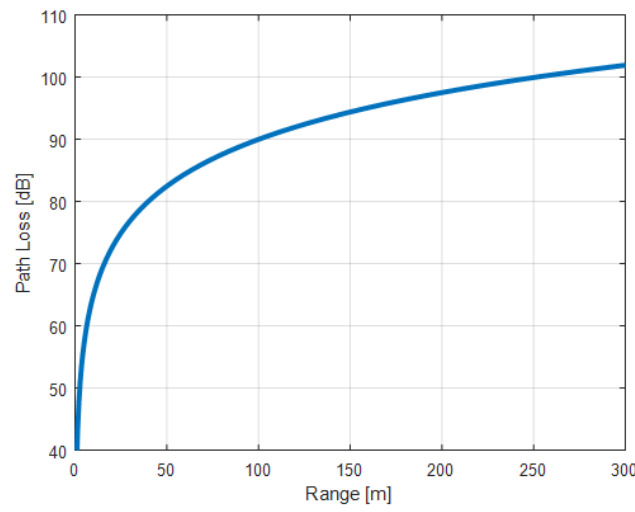
Figure 26. A graphic representation of path loss , obtained from Equation (6). Adapted from [55]. According to the BLE specification [53], a BLE receiver must have a sensitivity lower than or equal to − 70 dBm, while a transmitter could have its radio power included in a range from − 20 dBm (0.01 mW) to +20 dBm (100